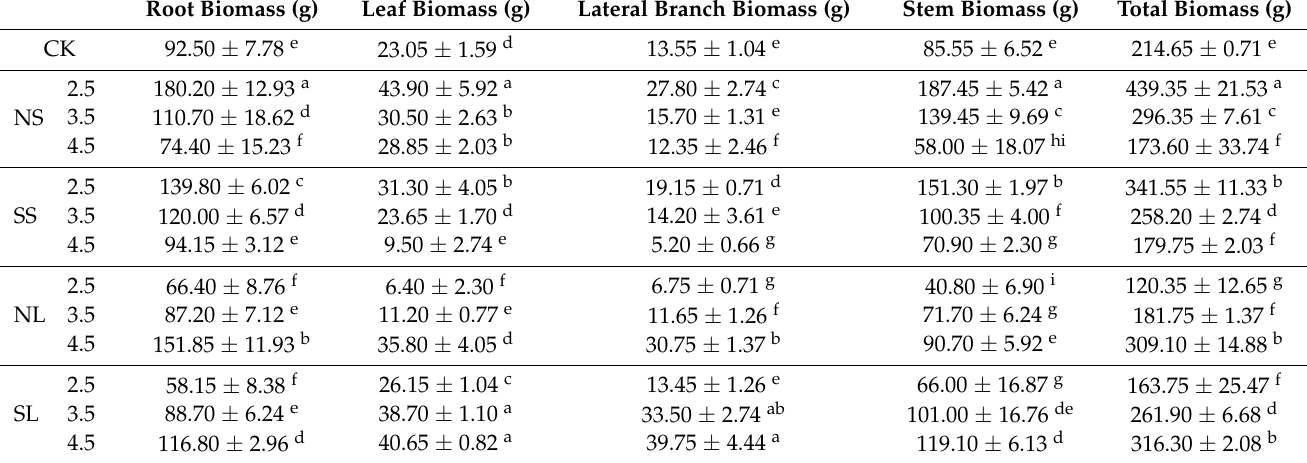
Table 2. Effects of different forms of acid stress on different parts of biomass and total biomass of A. catalpifolium. The treatments: CK, NS, NL, SS and SL are defined as control, nitric-balanced acid applied to soil, nitric-balanced acid applied to leaves, sulfuric-dominated acid applied to soil and sulfuric-dominated acid applied to leaves, respectively. Values are the average ± standard deviation (n = 10). Different superscript letters in each column indicated a significant difference among different acid treatments ( p <